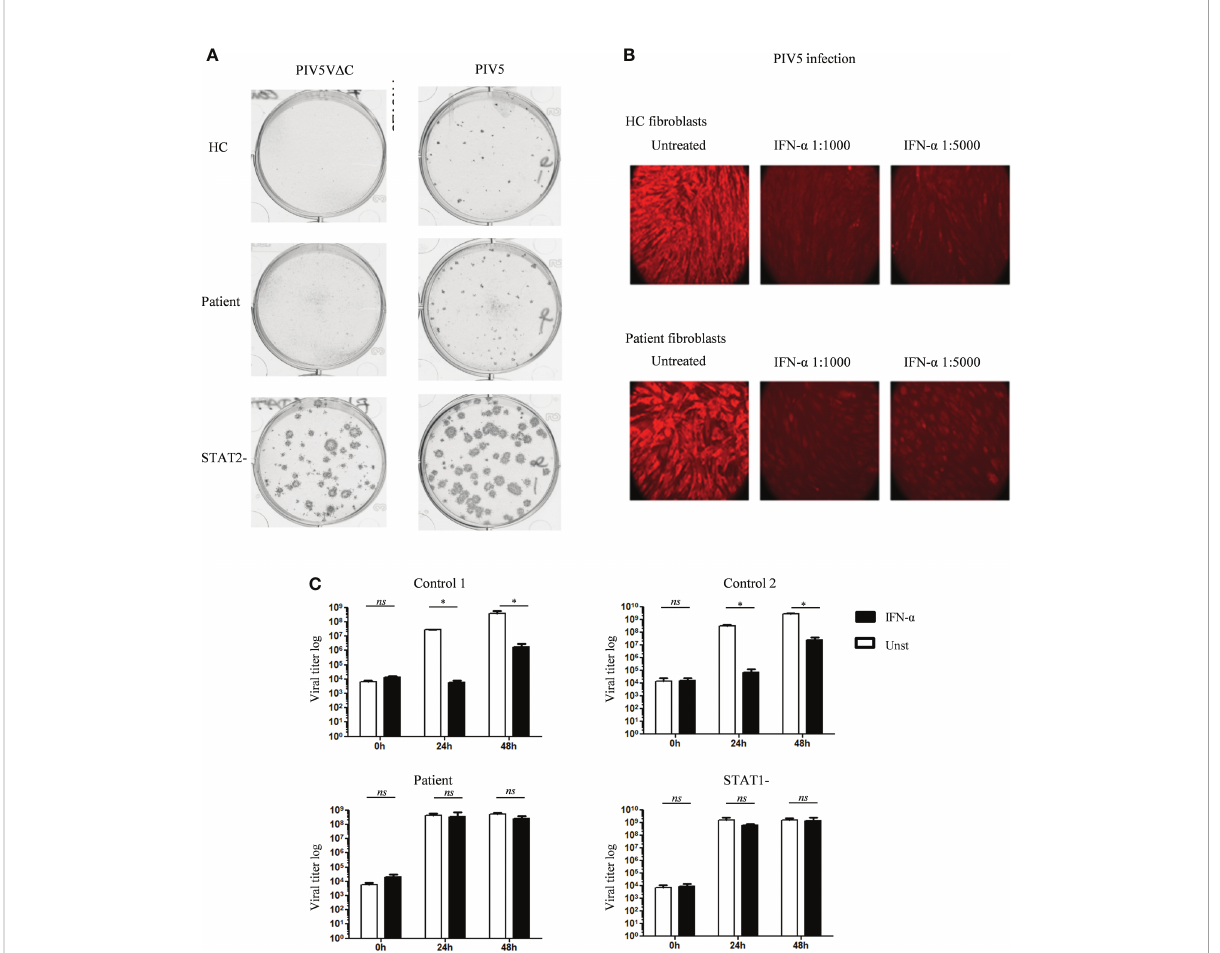
FIGURE 4 Variable in vitro antiviral response in fi broblasts and EBV B cells of the patient with JAK1 de fi ciency (A) Relative plaque sizes of the PIV5/PIV5V D C virus visualized by immunostaining in fi broblasts from patients with partial JAK1, complete STAT2 de fi ciency and healthy control. (B) Visualization of PIV5 virus-infected cells by immuno fl uorescence in control and JAK1 de fi cient patient fi broblast, with or without IFN- a pre- treatment. Data display a representative experiment from three independent experiments. (C) Determination of VZV viral load in EBV-B cells from the patient with partial JAK1, complete STAT1 de fi ciency, and two healthy controls (C1 and C2), with or without pre-treatment with IFN- a . Data is from three independent experiments. One-tailed Mann Whitney test. *P <0.05; NS, not signi fi